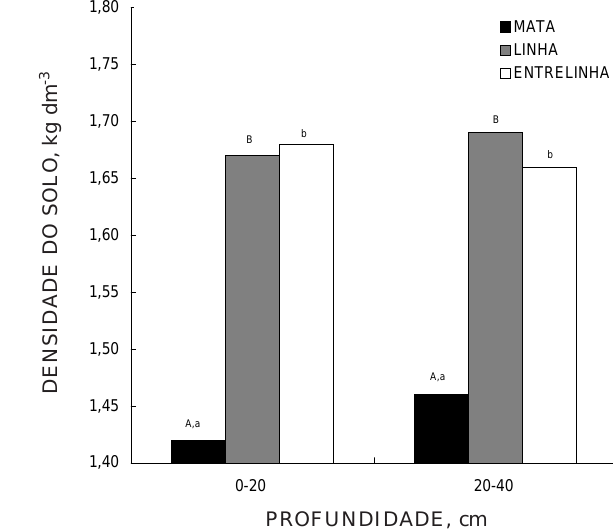
Figura 5. Valores médios de matéria orgânica, nas profundidades de 0-20 e 20-40 cm, para os três locais estudados. As letras maiúsculas comparam as áreas sob mata e linha da cultura, a 5% pelo teste t. As letras minúsculas comparam a mata e a entrelinha da cultura, a 5% pelo teste t.